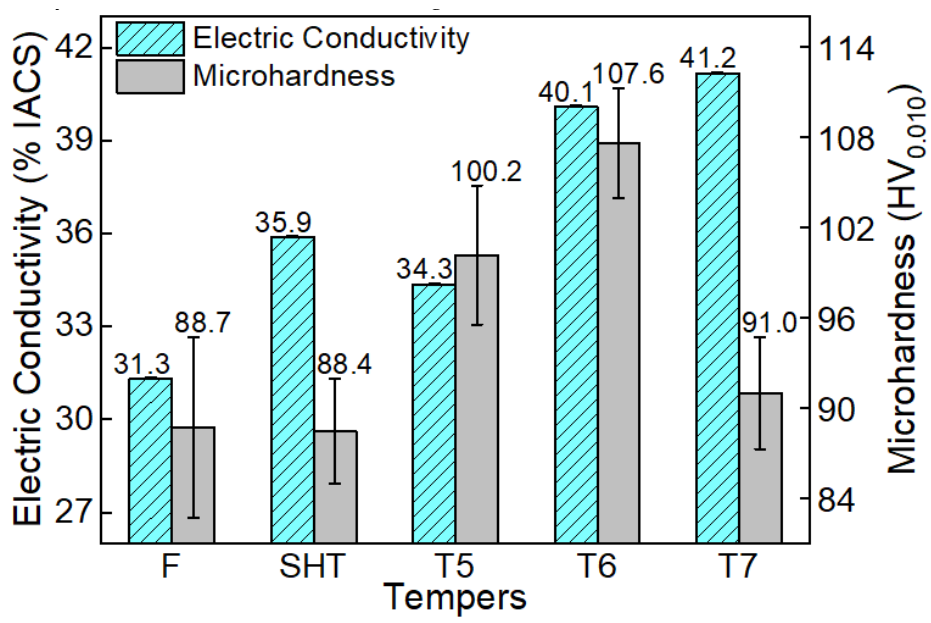
Figure 4. Electrical conductivity and microhardness after different treatments of AlSi10Mg0.3Mn alloy.